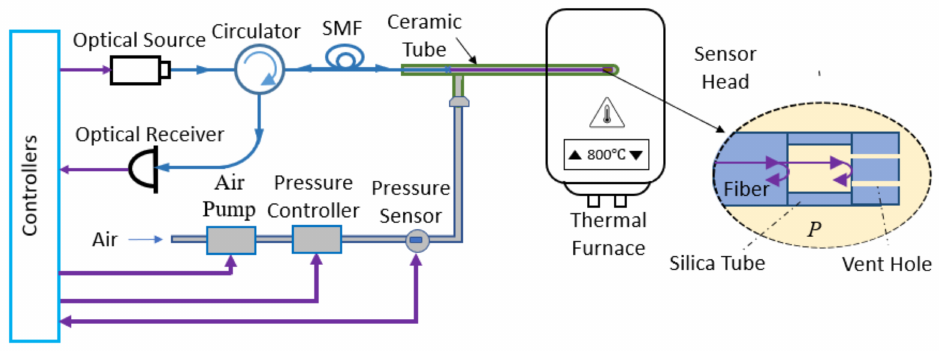
Figure 2. Schematics of the fiber optic temperature sensor system.